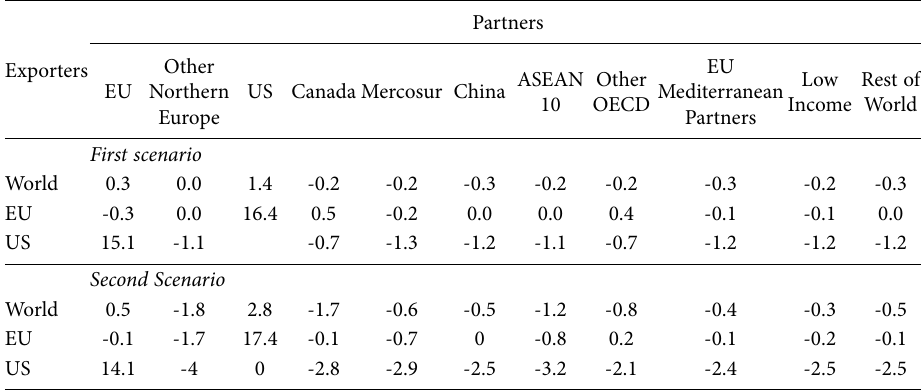
Table A2. Export volume by region for “crop products” [% change].